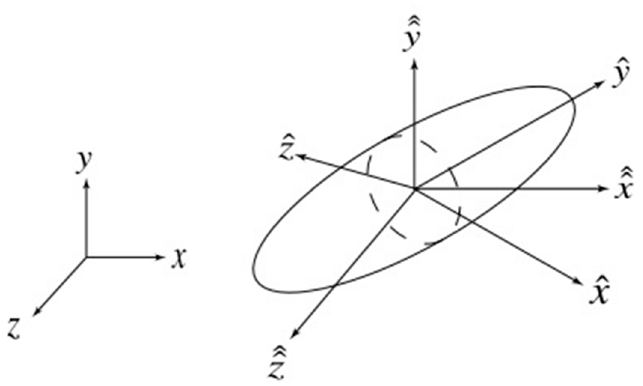
Figure 1. Coordinate system.